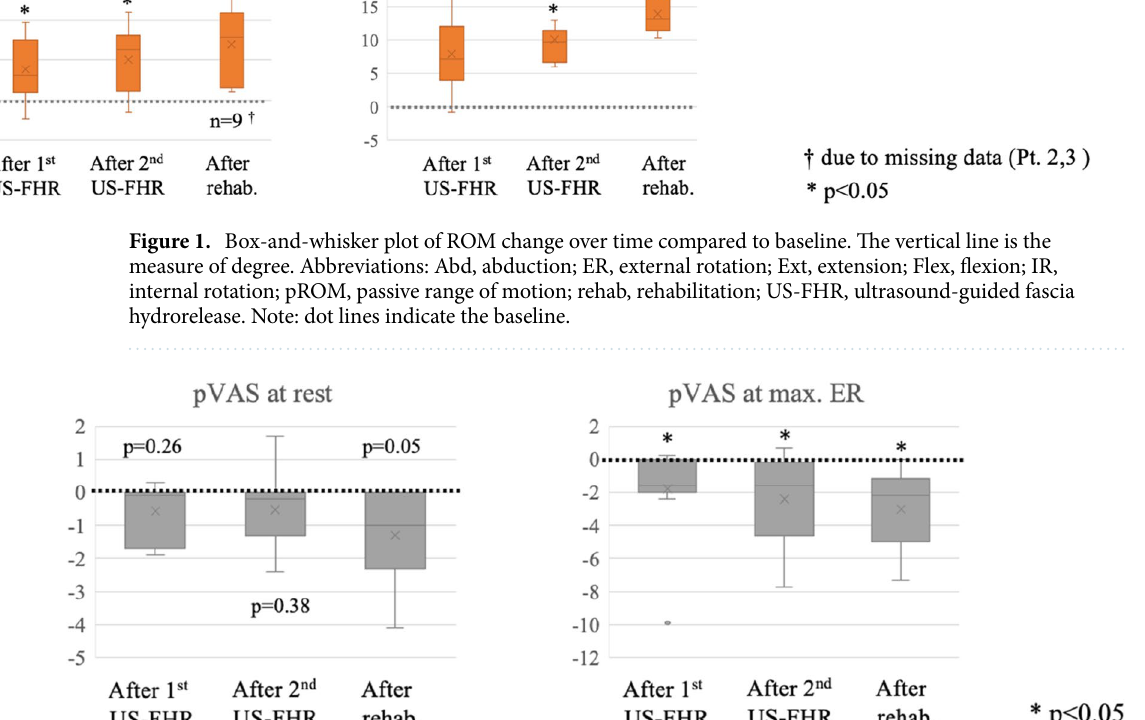
Figure 2. Box-and-whisker plot of pVAS change over time compared to the baseline. The pVAS at rest is scored at rest, and pVAS at max.ER is at maximal ER (on move), separately. Abbreviations: Abd, ER, external rotation; pVAS, pain visual analog scale; rehab, rehabilitation; US-FHR, ultrasound-guided fascia hydrorelease. Note: dot lines indicate the